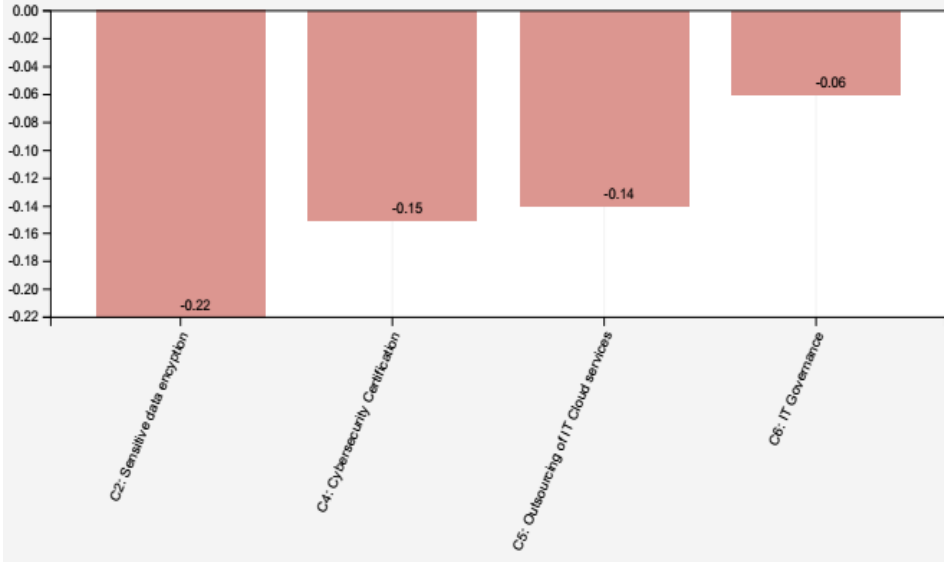
Figure 5. Scenario II: analysis cybersecurity in telehealth .